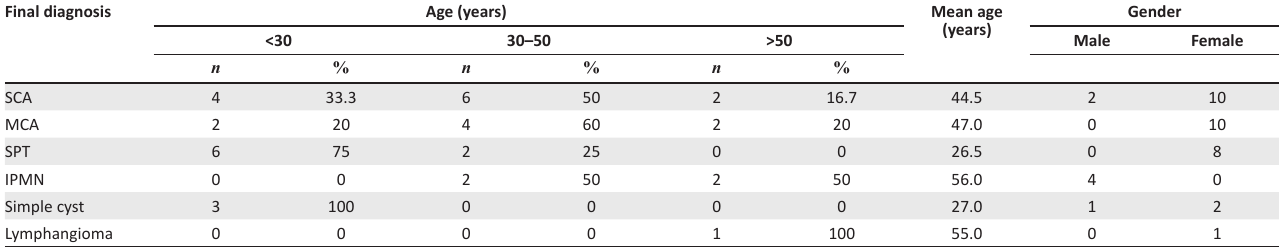
TABLE 1: Age, mean age (in years) and gender distribution of various pancreatic cystic lesions at the time of diagnosis. Final